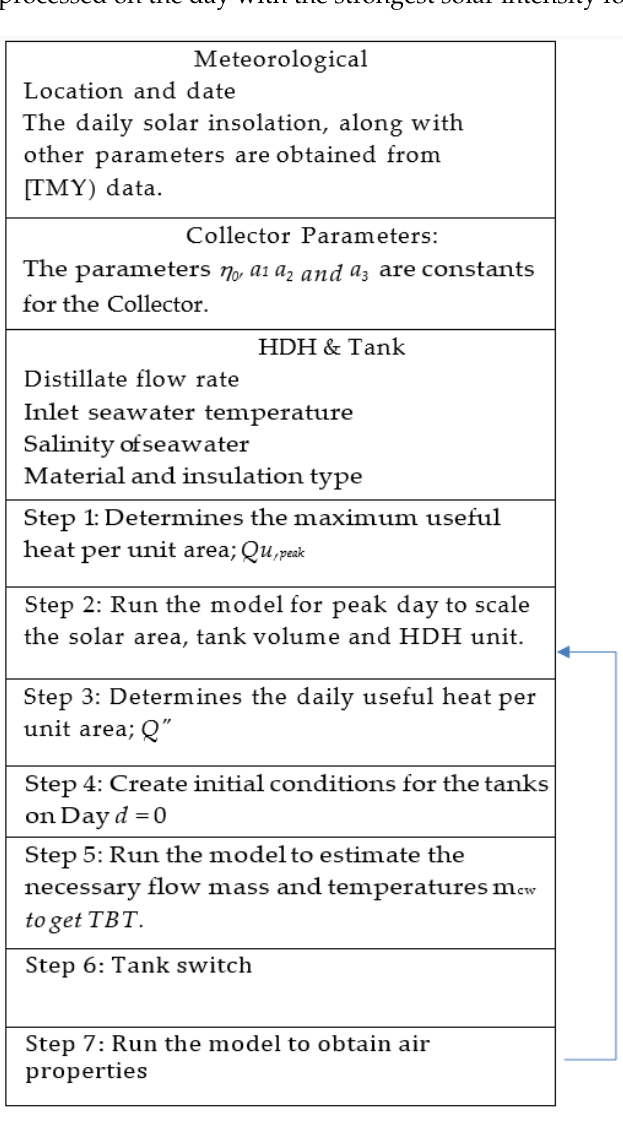
Figure 3. Process steps for the dynamic model .